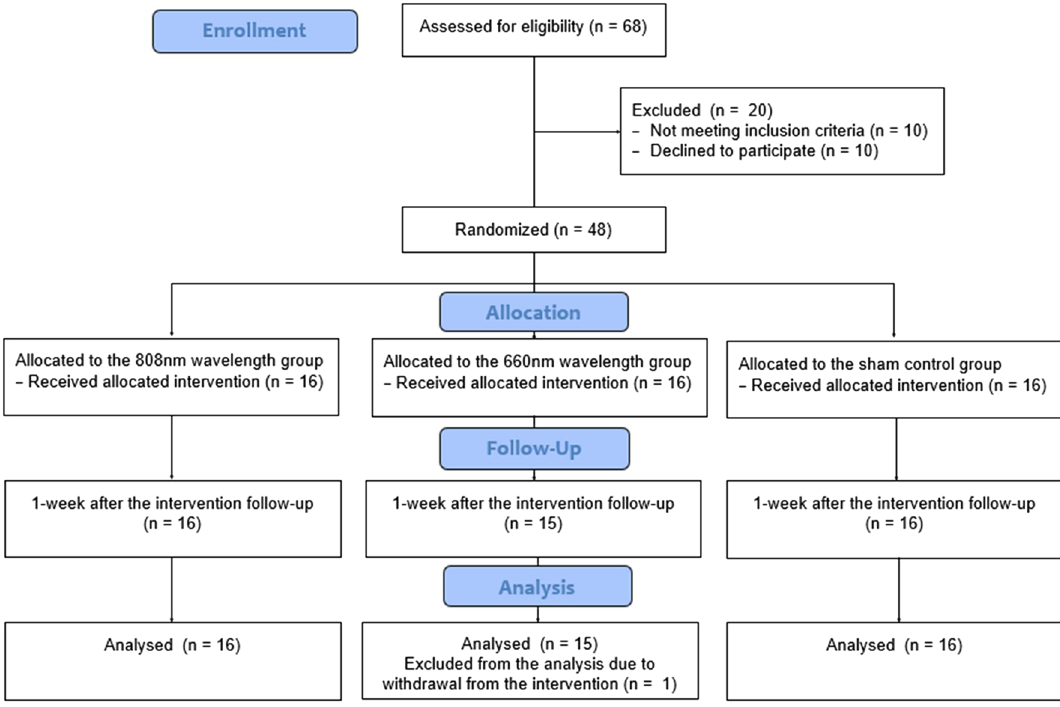
Figure 1. CONSORT flowchart of the